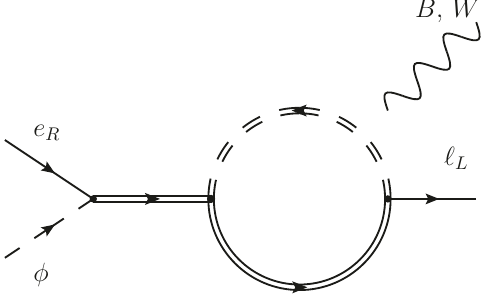
Figure 2 . Bridge topology for the fermionic bridge with an extra heavy fermion and a heavy scalar. Double lines represent heavy particles, whereas single lines are SM particles. The gauge boson ( B or W ) is represented outside the diagram since it can be attached to any of the internal